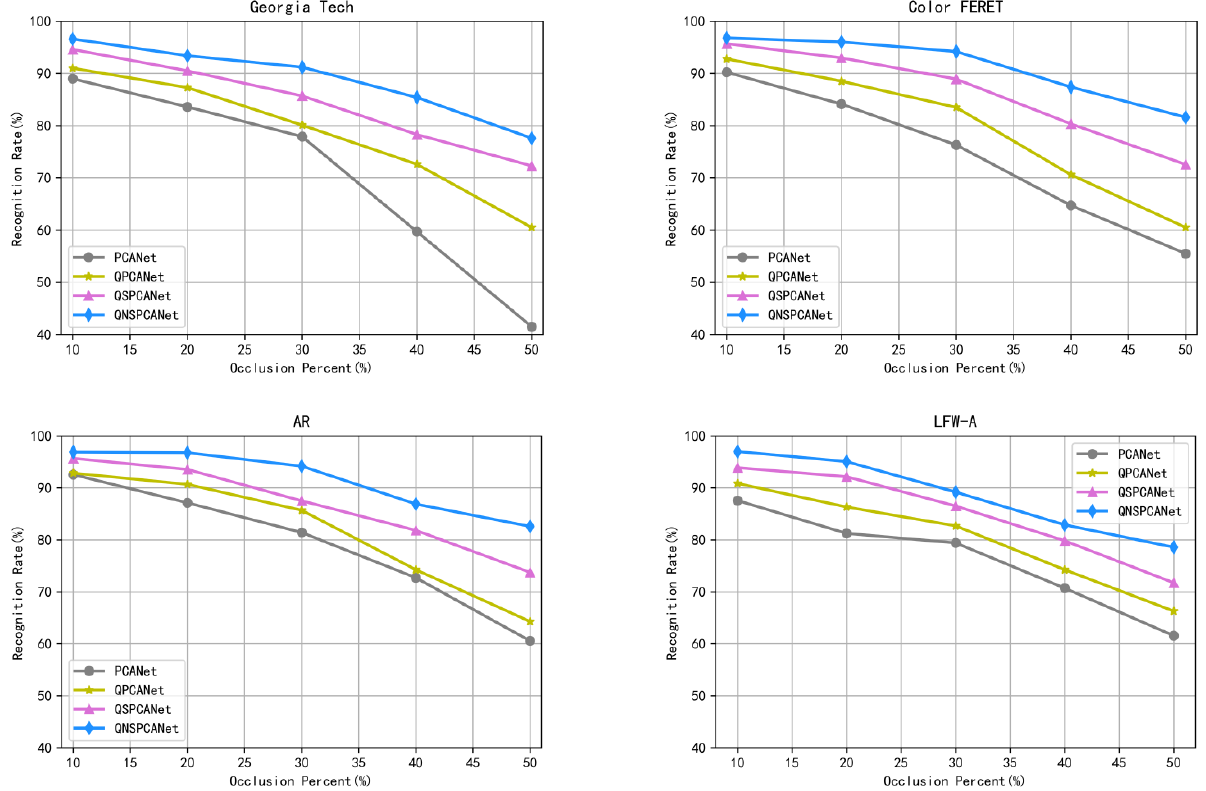
Figure 4. The recognition rate curves of each algorithm under different solid color occlusion